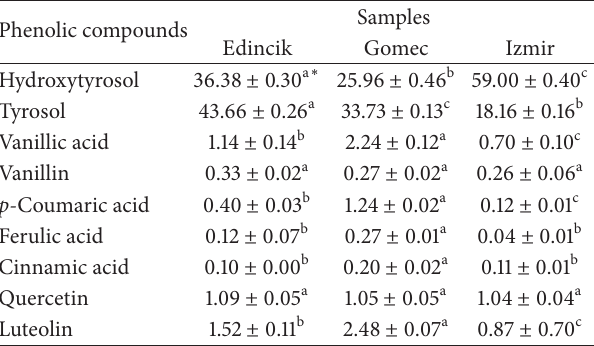
Table 4: Phenolic compounds of virgin olive oil samples